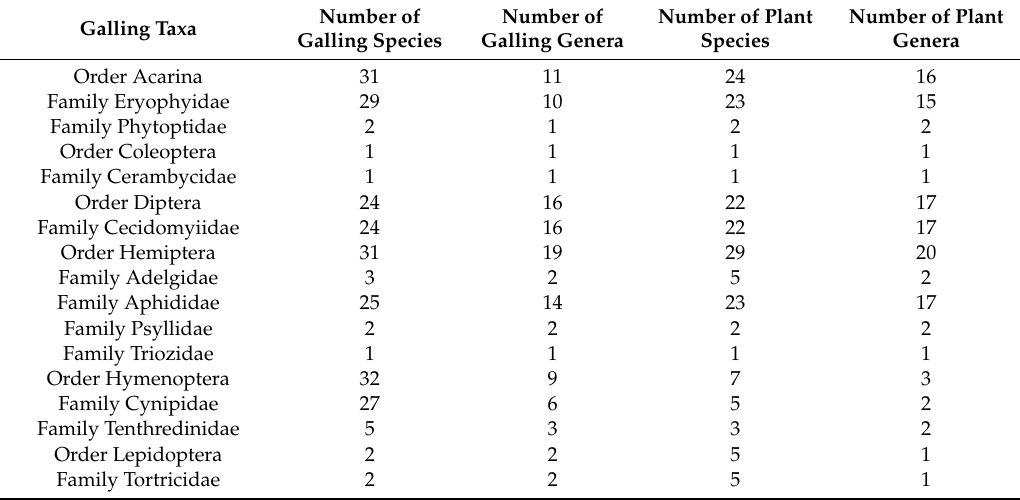
Table 1. Diversity of galling arthropods and host plants recorded in the Nitra City Park (Nitra, SW,